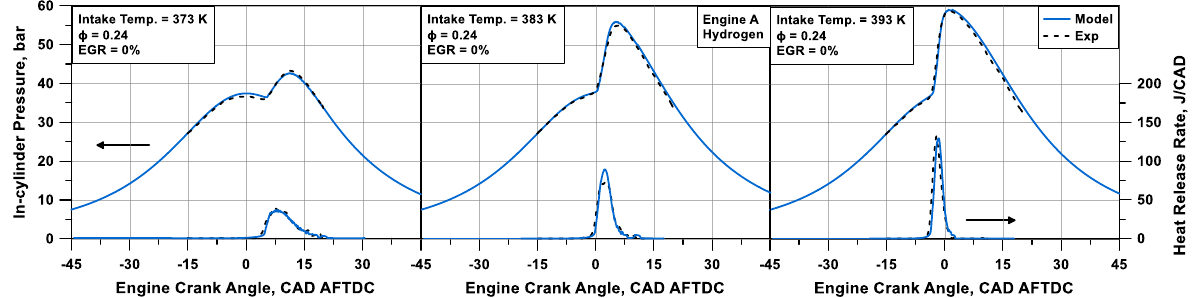
Figure 10. Numerical/experimental comparison of in-cylinder pressure traces and heat release rate profiles for Engine A.